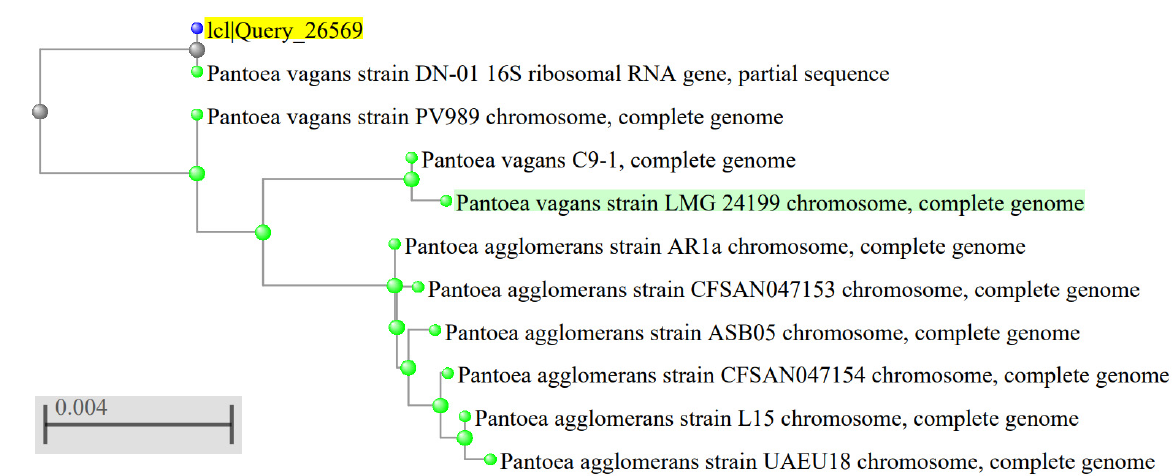
Figure 2. A phylogenetic tree based on neighbor-joining method. Created by phylogenetic tree function in BLAST tool. The sequence of the bacterial strain was designated IcI Query_ 26569 (denoted by blue circle and highlighted in yellow), The best match Pantoe vagans strain LMG 24199 (denoted by green circle and highlighted in green) using phylogenetic tree in BLASTn tool.